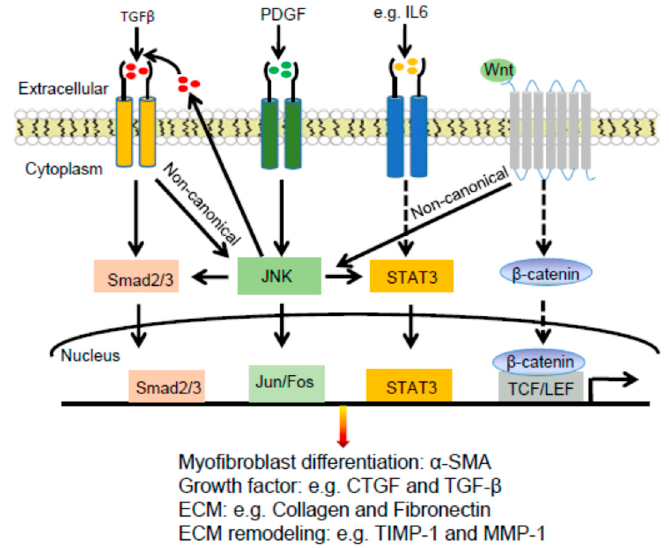
Figure 4. JNK enhances fibrosis via crosstalk with TGF β , PDGF, STAT3, and WNT signaling pathways. JNK acts downstream of TGF β , PDGF, and Wnt signaling pathways to regulate expression of profibrotic genes. In addition, JNK enhances TGF β secretion, and crosstalk with STAT3 to further enhance pro-fibrosis. The dashed lines show the canonical STAT3 and WNT signaling pathways which are not discussed in the review.